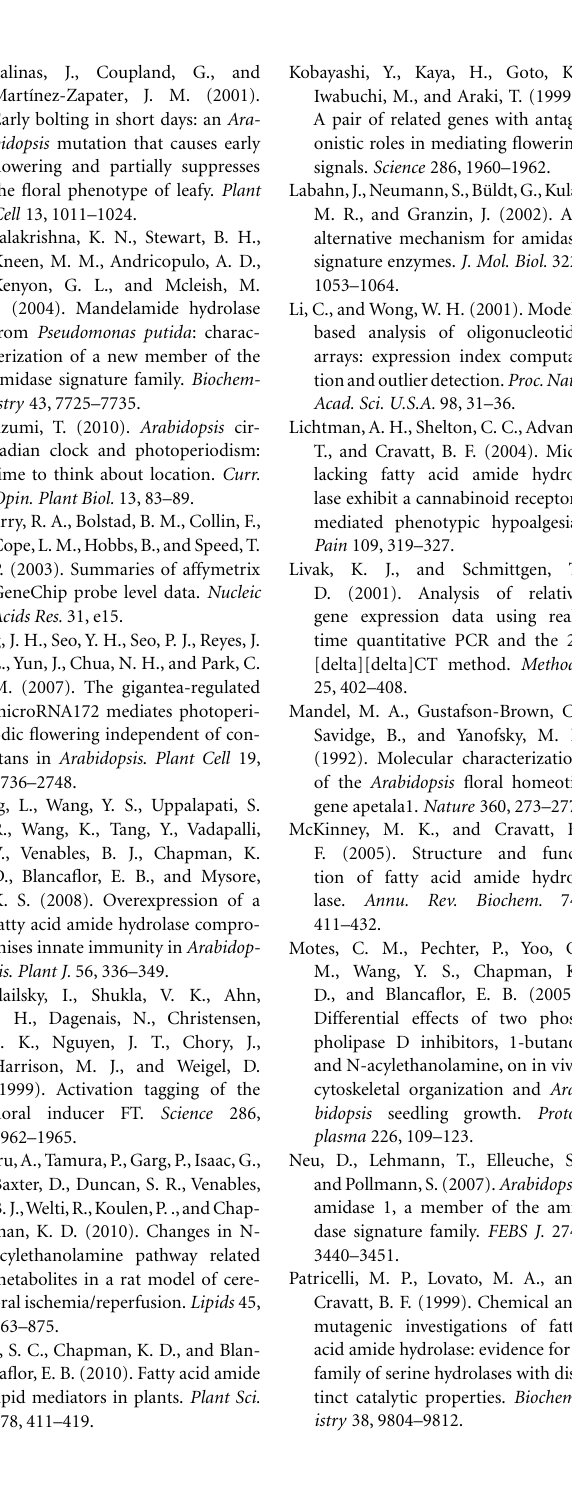
Table S2 | Genes downregulated twofold or more in both AtFAAH overexpressors and AtFAAH